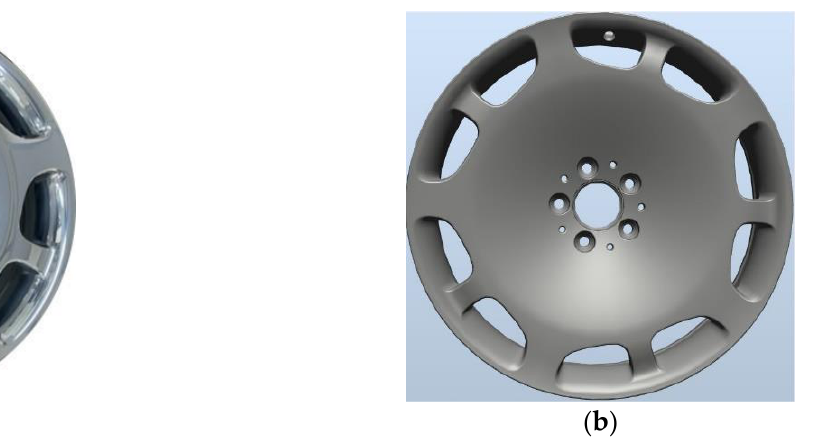
Figure 2. ( a ) Image of actual aluminum rim; ( b ) numerical rendering of the aluminum rim.